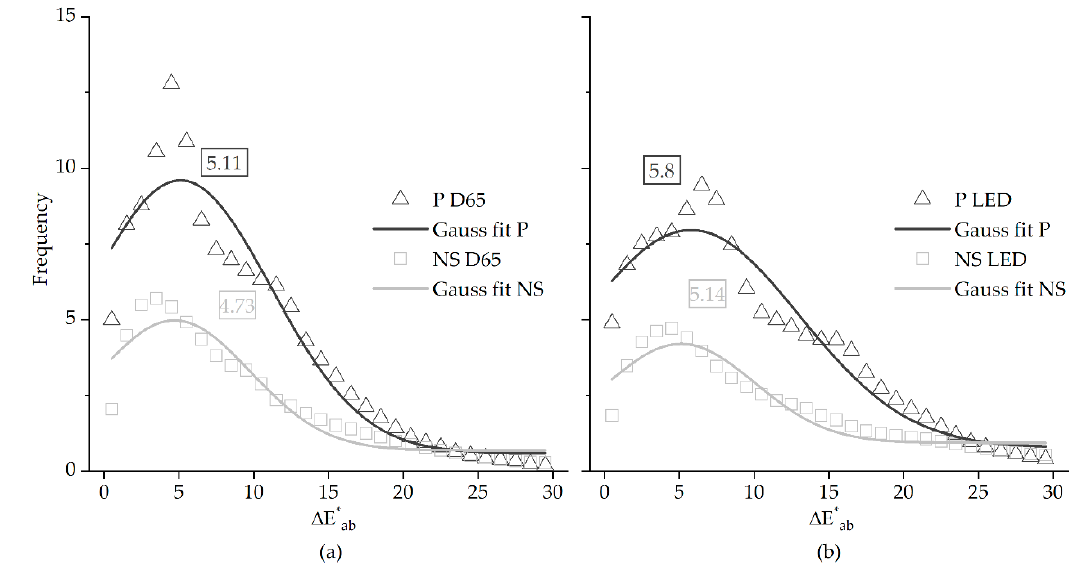
Figure 5. Color di ff erence errors ( ∆ E * ab ) in the CIELAB color space between the colors obtained for the CIE 1931 standard observer (OBS) and the digital camera (RGB), computed for paintings (open triangles) and natural scenes (open squares) under the CIE D65 (panel ( a )) and the LED (panel ( b )) illuminants. Full lines represent the best fit to the data of a Gaussian function. The numbers depicted correspond to the maximum color error ( ∆ E * ab ) extracted from the function fitted.